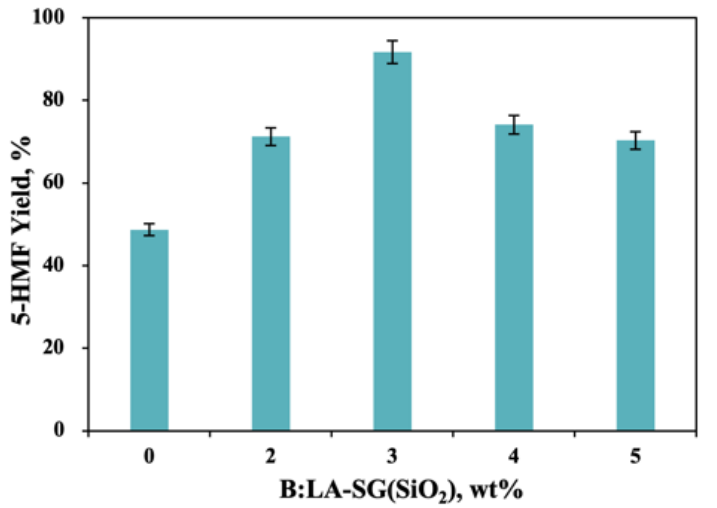
Figure 3. Effect of solid acid dose (SG(SiO 2 ) 0–5 wt%) on the 5-HMF formation [B:Gly 20 wt%, 150 °C, 1.5 h].